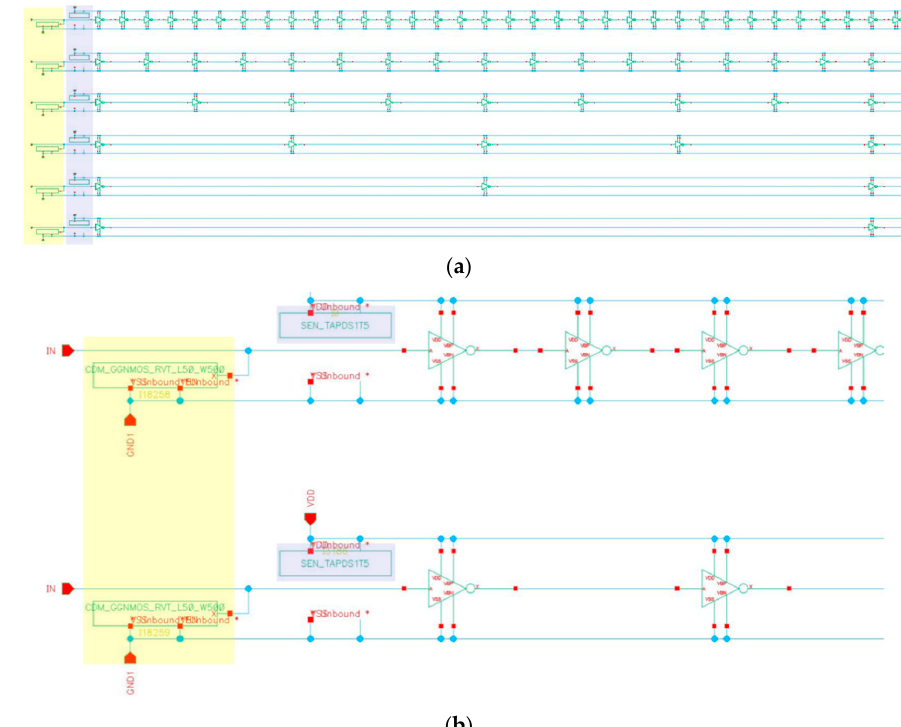
Figure 5a is a snapshot of the implemented schematic of the described structure. The whole schematic could not be captured and only a part of it is shown here. Figure 5b is a zoomed area of the schematic, where the tap cell, together with filler cell and the inverters can be seen.